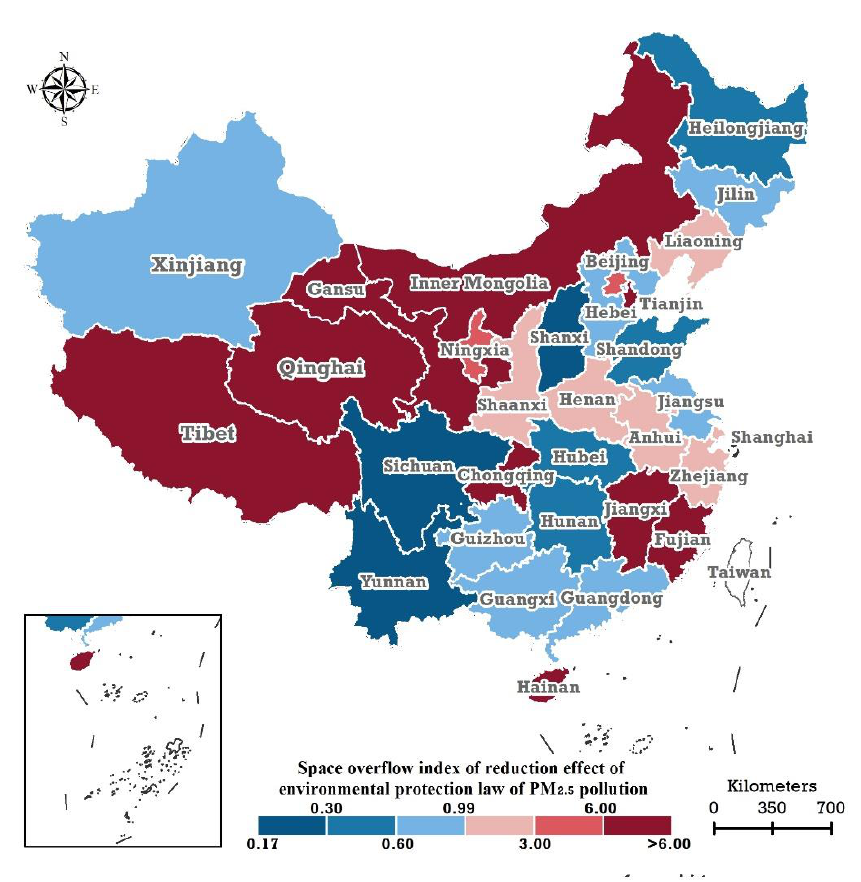
Figure 4. Spatial distribution of the spatial spillover index of the abatement effects of the Environ- mental Protection Tax Law on 𝑃𝑀 2.5 pollution in the 31 provincial regions of the Chinese mainland. Specifically, an SSI of less than 1.0 was observed for 14 provincial regions (blue in Figure 4), namely Shanxi, Yunnan, Sichuan, Hubei, Guangxi, Shandong, Hebei, Hunan, Xinjiang, Jilin, Guangdong, Jiangsu, Guizhou, and Heilongjiang, where the minimum and maximum are 0.21 and 0.99. There are 17 provincial regions where the SSIs were greater than 1.0 (red in Figure 4): Liaoning, Henan, Zhejiang, Anhui, Ningxia, Shanghai, Shaanxi, Qinghai,